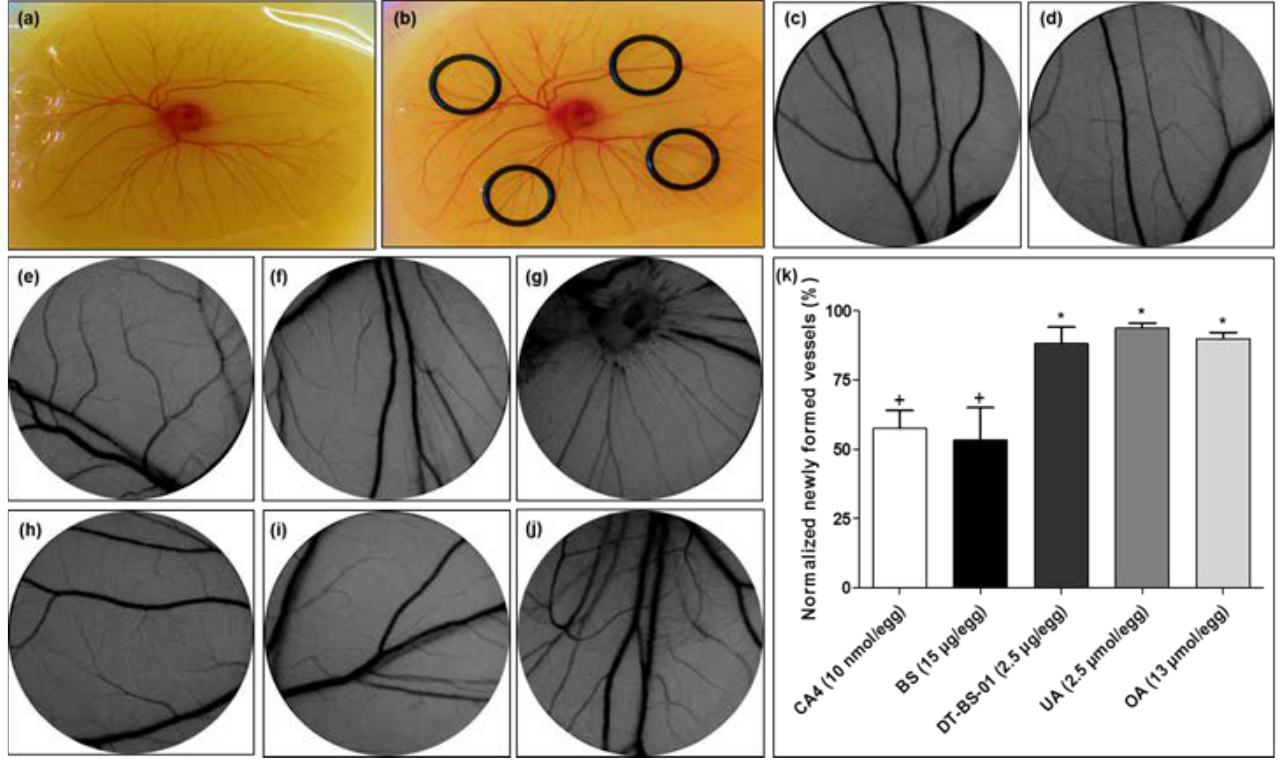
Figure 8. Images of ( a ) chick embryo, and ( b ) O-rings placed on the membrane for sample addition. Representative images of yolk sac membrane (YSM) treated for 24 h with ( c ) phosphate-buffered saline, ( d ) 0.3% DMSO (vehicle) control, ( e ) 3% DMSO (vehicle) control, ( f ) combretastatin A4 (10 nmol/egg), ( g ) Buddleja saligna extract (BS: 15 µg/egg), ( h ) isolated triterpenoid mixture (DT − BS − 01: 2.5 µg/egg), ( i ) ursolic acid (2.5 µmol/egg) and ( j ) oleanolic acid (10 µmol/egg). ( k ) Normalized newly formed vessels (%) in YSM after treatment for 24 h. Data was expressed as mean ± SD ( n = 2). * p < 0.05 indicates statistical difference when compared to the CA4 positive control (+), whereas (+) for BS, indicates statistically similar results to CA4. Statistical analysis was done using one-way ANOVA followed by Tukey’s Multiple Comparison Test.